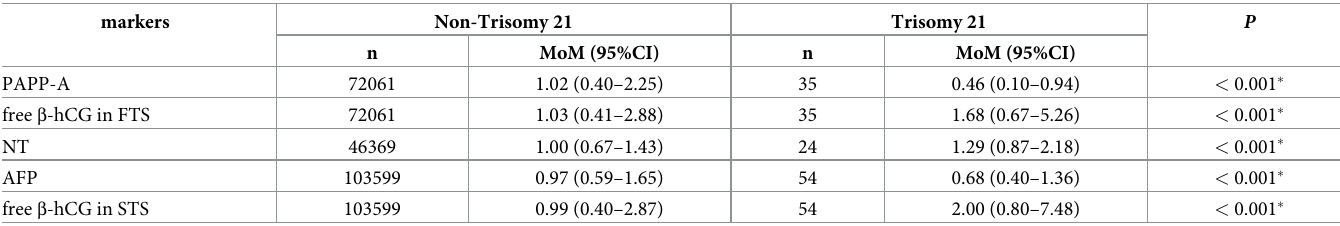
Table 5. Distribution of marker MoM values in the serum of pregnant women with or without trisomy 21 fetuses. markers Non-Trisomy 21